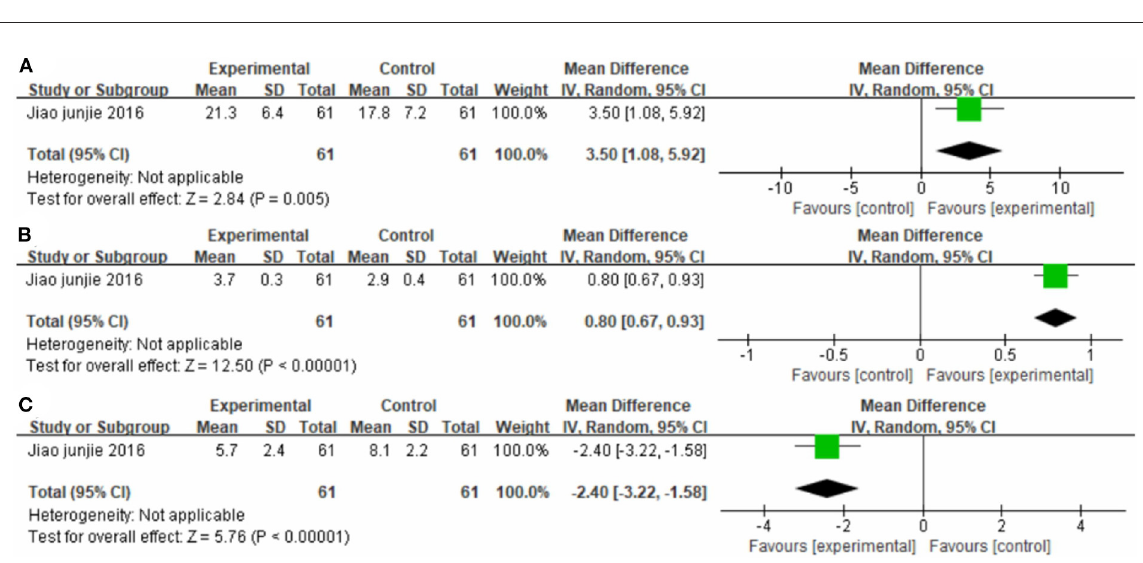
FIGURE13 Forest plot. CIMT plus western medicine therapy vs. western medicine therapy alone on the Fugl-Meyer Assessment lower limb sub-scale (A) , functional ambulation category scale (B) and National Institute of Health stroke scale (C) .